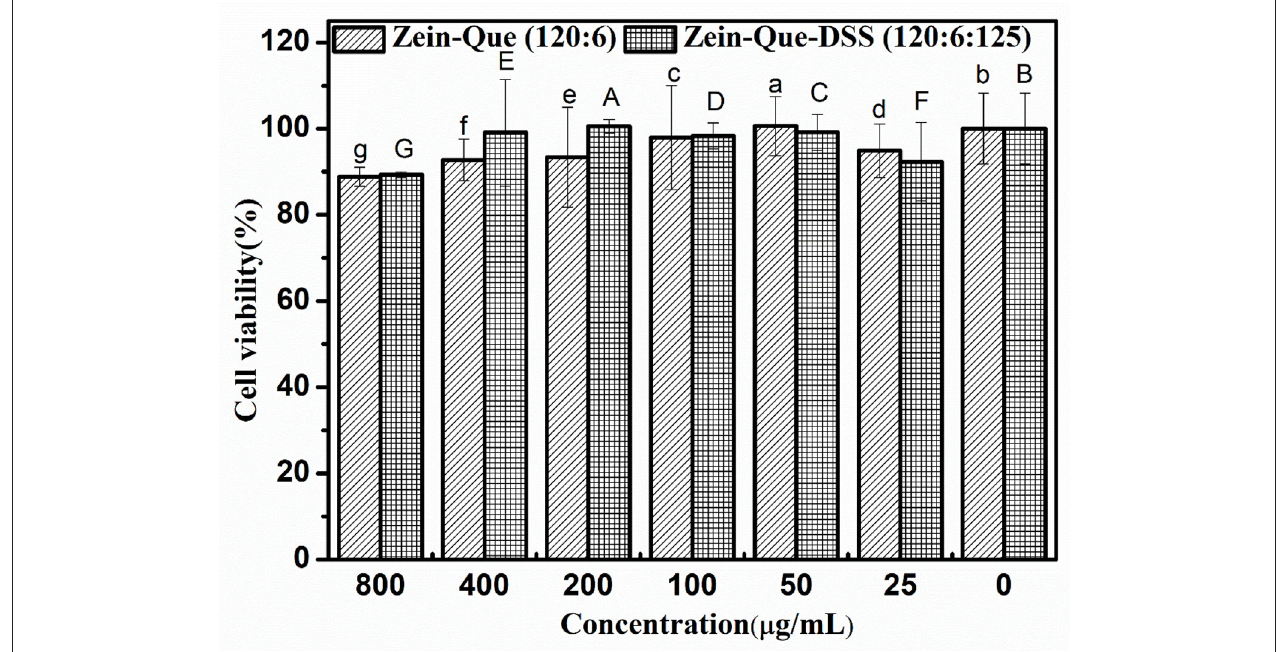
FIGURE 8 | Cell viability of Caco-2 cells intervened by Zein-Que (120:6) nanoparticles and Zein-Que-DSS (120:6:125) complex nanoparticles with different concentrations. Different superscript letters in the same column represent significant differences ( p < 0.05).